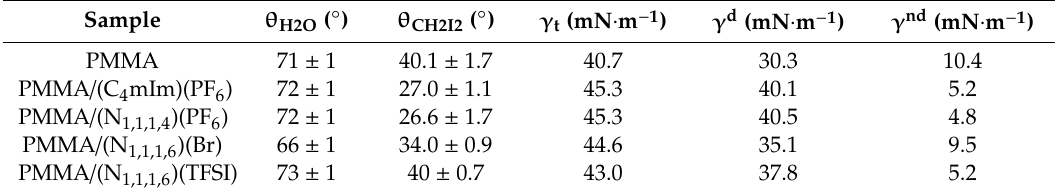
Table 3. Determination of nondispersive and dispersive components of the surface energy of neat PMMA and IL-modified PMMA materials from contact angles with water and